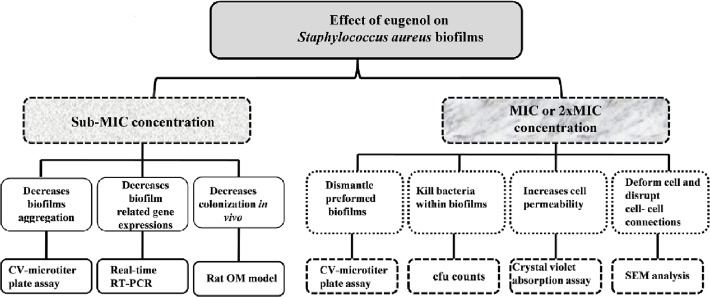
Systematic diagram showing effect of eugenol on Staphylococcus aureus biofilms.